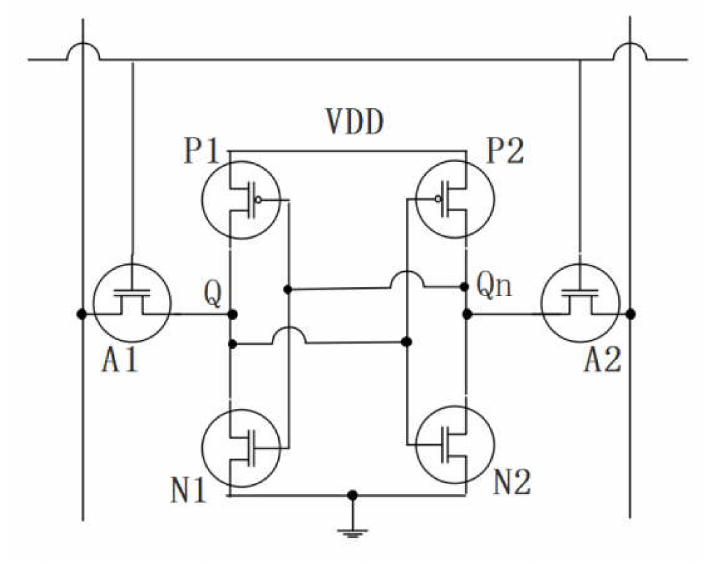
Figure 2. Schematic of 6T static random-access memory (SRAM)